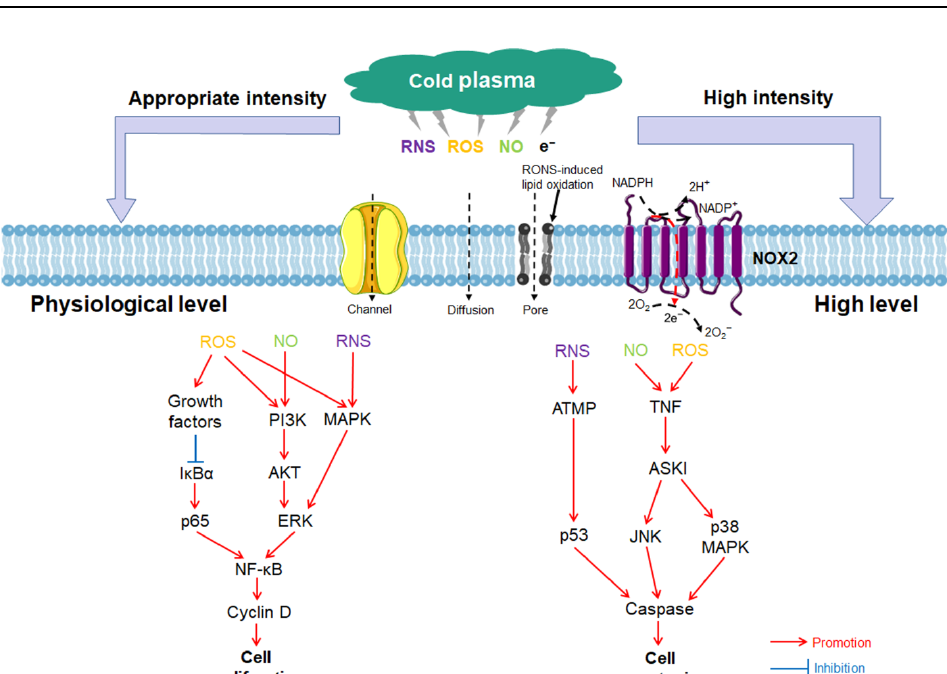
Figure 2. Mechanisms of cold plasma treatment in cell activity. Cold plasma-producing bioactive substances, such as reactive oxygen species (ROS), reactive nitrogen species (RNS), and nitric oxide (NO), affect cell activity in an intensity-dependent manner. Cold plasma-producing reactive oxygen and nitrogen species (RONS), NO, and e - may cross a cell membrane barrier to reach the cell interior through a membrane channel, a passive diffusion process, or pores generated by lipid oxidation. nicotinamide adenine dinucleotide phosphate oxidase 2 (NOX2) can reduce oxygen molecules to superoxide anions through the NADPH-dependent single-electron reduction process. Appropriate intensity cold plasma produces a physiological level of bioactive substances, which may promote cell proliferation through regulating cell cycle progression that is mediated by mitogen-activated protein kinase (MAPK)/extracellular regulated protein kinase (ERK), phosphoinositide 3-kinase (PI3K)/AKT/ERK, and nuclear factor kappa-B (NF- κ B) signaling pathways. High-intensity cold plasma generates a high dose of bioactive substances, which may induce cell apoptosis through regulating p53, Jun nuclear kinase (JNK), and p38 MAPK-mediated caspase